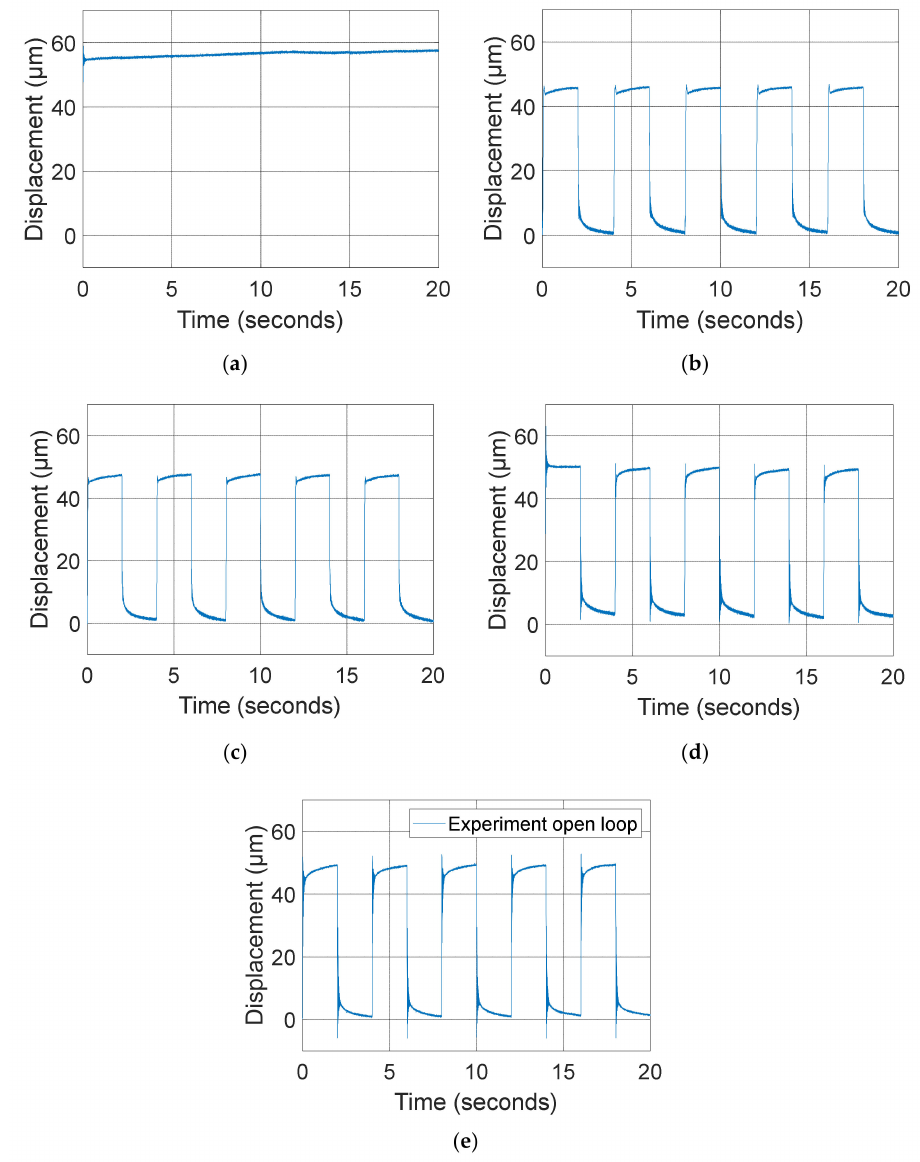
Figure 6. LQR closed-loop experimental response when varying Q while R = 0.01: ( a ) Q = 700,000 ( b ) Q = 70, 000 ( c ) Q = 7,000; ( d ) Q = 700, and ( e ) Open-loop